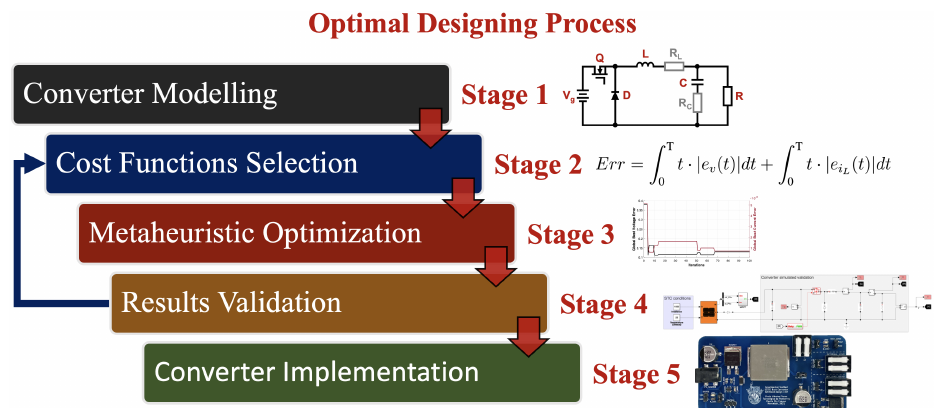
Figure 9. Optimal design methodology applied for this case study.